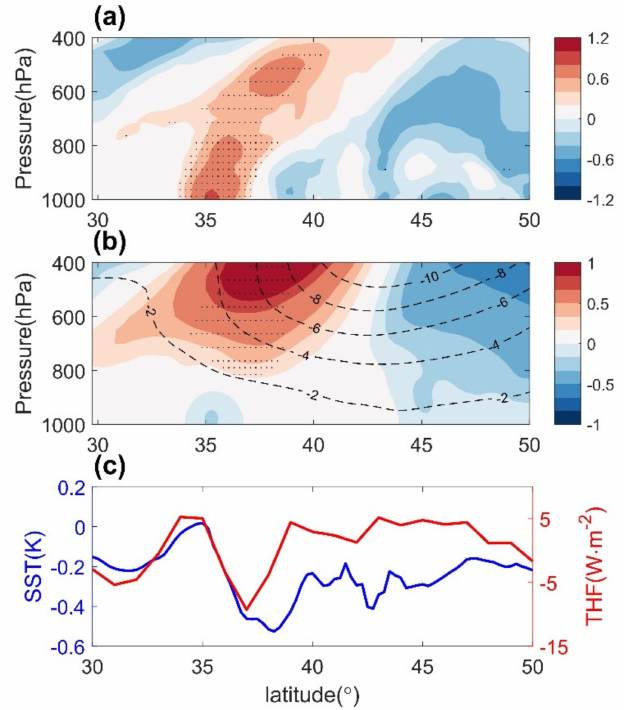
Figure 9. The estimated responses of ( a ) meridional temperature gradient (shading, unit: 10 − 6 Km − 1 ), ( b ) zonal winds (shading, unit: ms − 1 ), geopotential height (contour, unit: gpm), ( c ) SST (blue line, unit: K, left ordinate) and THF (red line, unit: Wm − 2 , right ordinate) averaged between 140 ◦ E and 150 ◦ E. Stippling indicates the 90% confidence level. The meridional temperature gradient is multiplied by − 1. A positive value indicates the meridional temperature gradient is